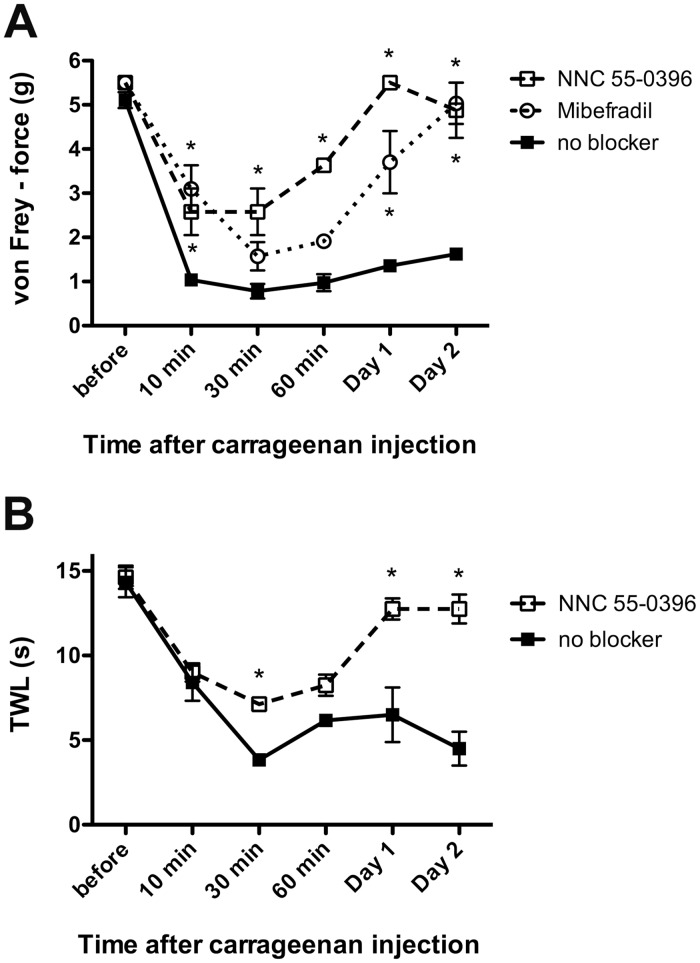
(A) The T-type calcium channel blockers NNC 55–0396 and mibefradil inhibit inflammatory mechanical hyperalgesia. Threshold mechanical force for paw withdrawal (PWT) values during preceding and periodic intraplantar treatments with or without the blocker are indicated. (n = 3 mice for NNC 55–0396, n = 4 mice for mibefradil and n = 19 mice for no blocker). (B) NNC 55–0396 also inhibits inflammatory thermal hyperalgesia. The thermal withdrawal latencies (TWLs) from the hot-plate test during preceding and periodic intraplantar treatments with or without the blocker are indicated (n = 3 mice for NNC 55–0396 and n = 3 mice for no blocker). *p < 0.05 compared with the respective control (no blocker) (two-way ANOVA with the Bonferroni post hoc test). n.s., not significant.